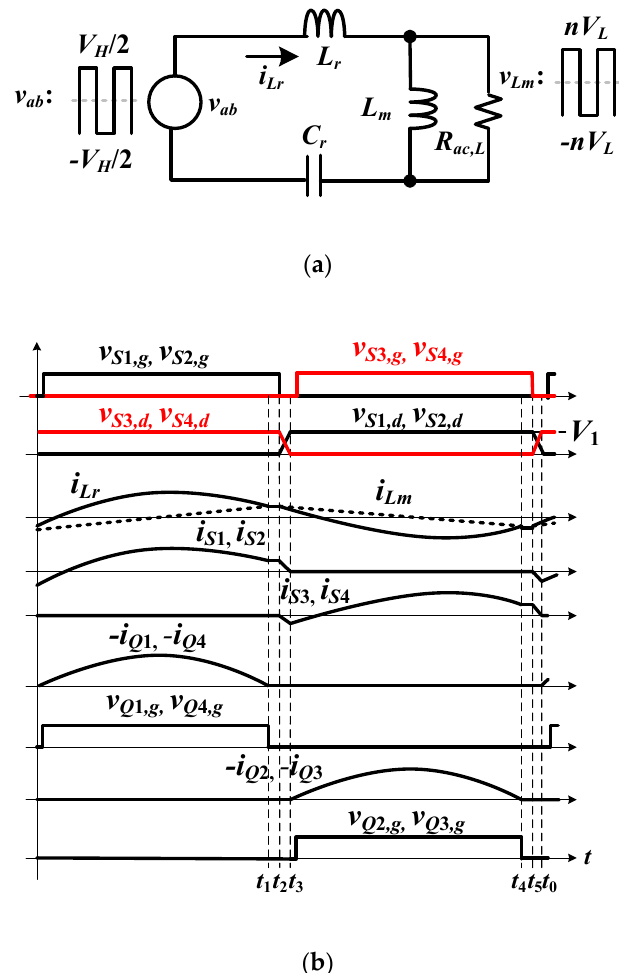
Figure 2. Forward power operation ( a ) the equivalent LLC resonant circuit ( b ) pulse-width modulation (PWM) waveforms.